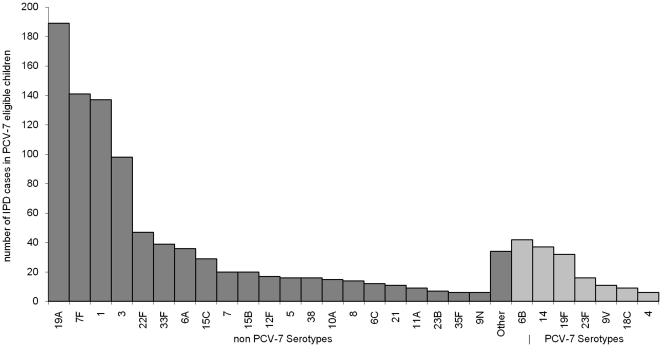
Serotype distribution of IPD cases included in the study.Enhanced surveillance serotyped IPD cases from England and Wales with known vaccination status from November 2006 to May 2010. Dark grey bars are PCV-7 serotypes and light grey bars non PCV-7 serotypes.